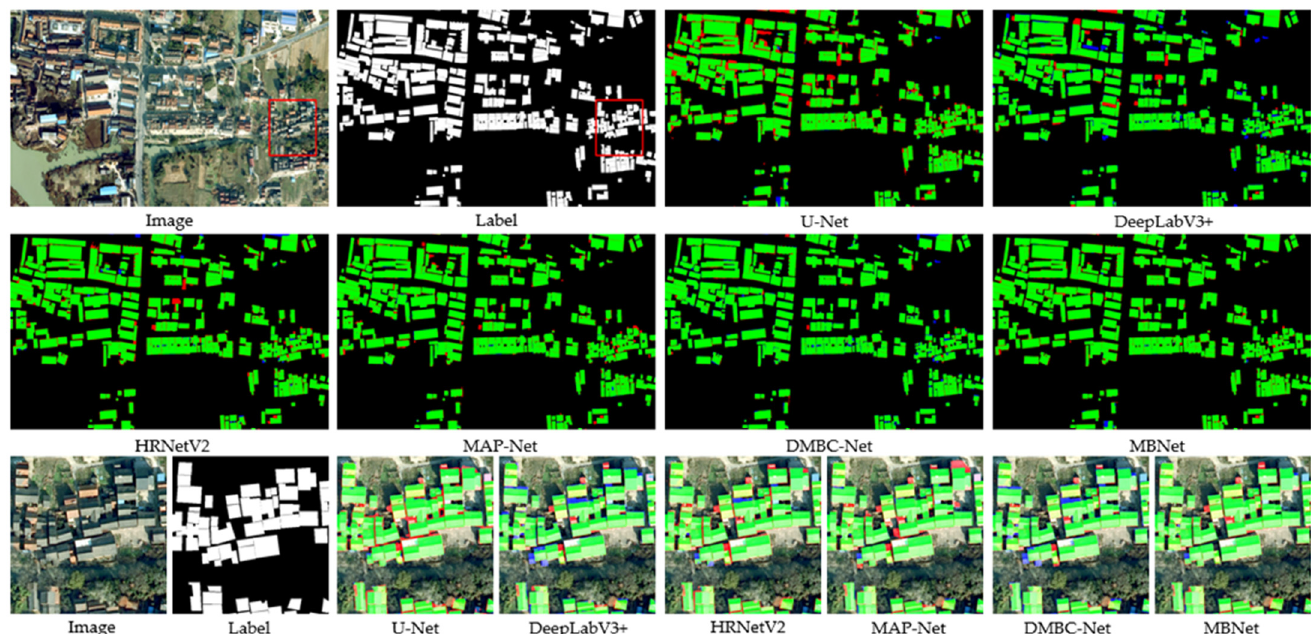
Figure 12. Segmentation results of the different SOTA methods on the hilly landform scene 1 test dataset. The bottom row is a close-up view of the red box.